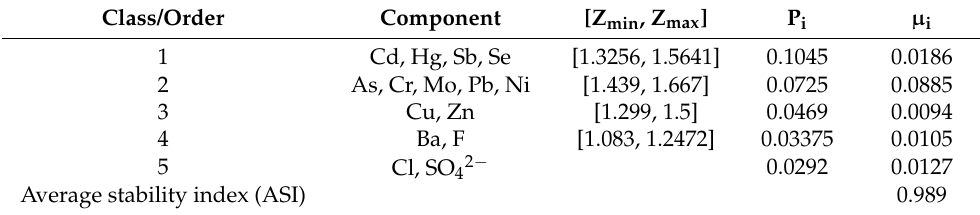
Table 5. Estimation of